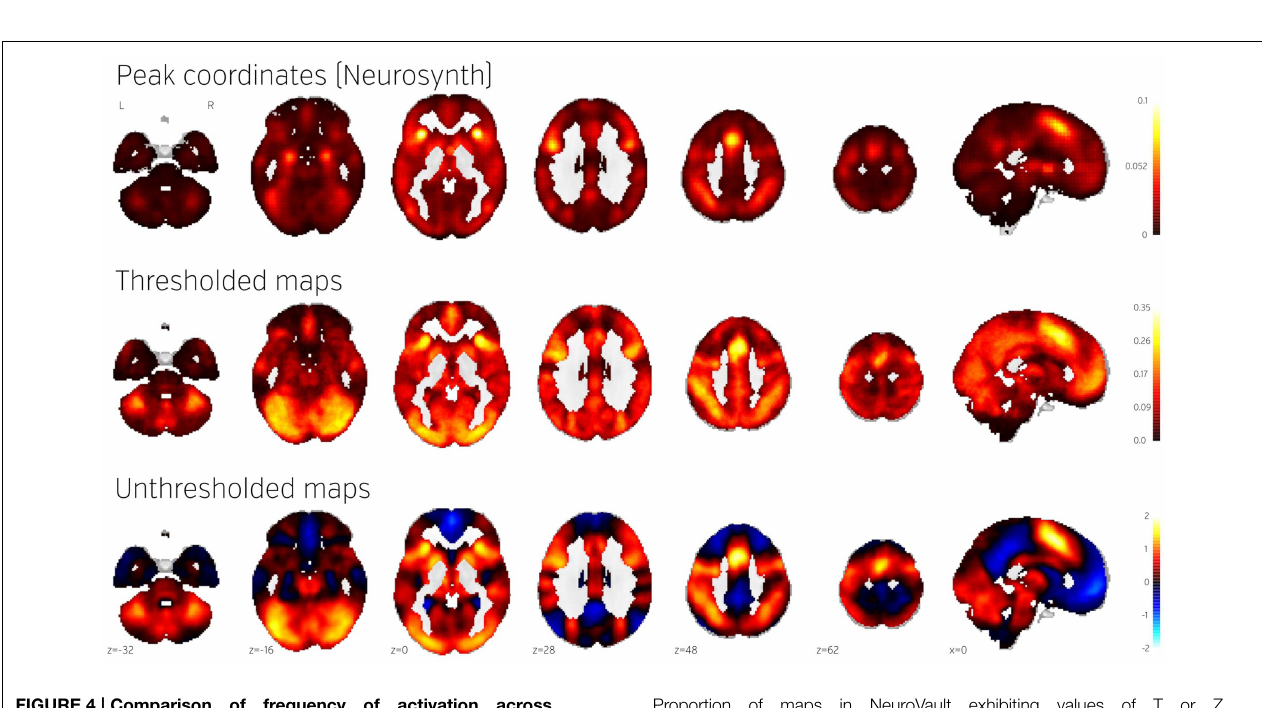
Proportion of maps in NeuroVault exhibiting values of T or Z higher than 3. Bottom : Mean of all T and Z maps (also deposited in NeuroVault). Maps from this figure are available at http://neurovault.org/collections/439/.